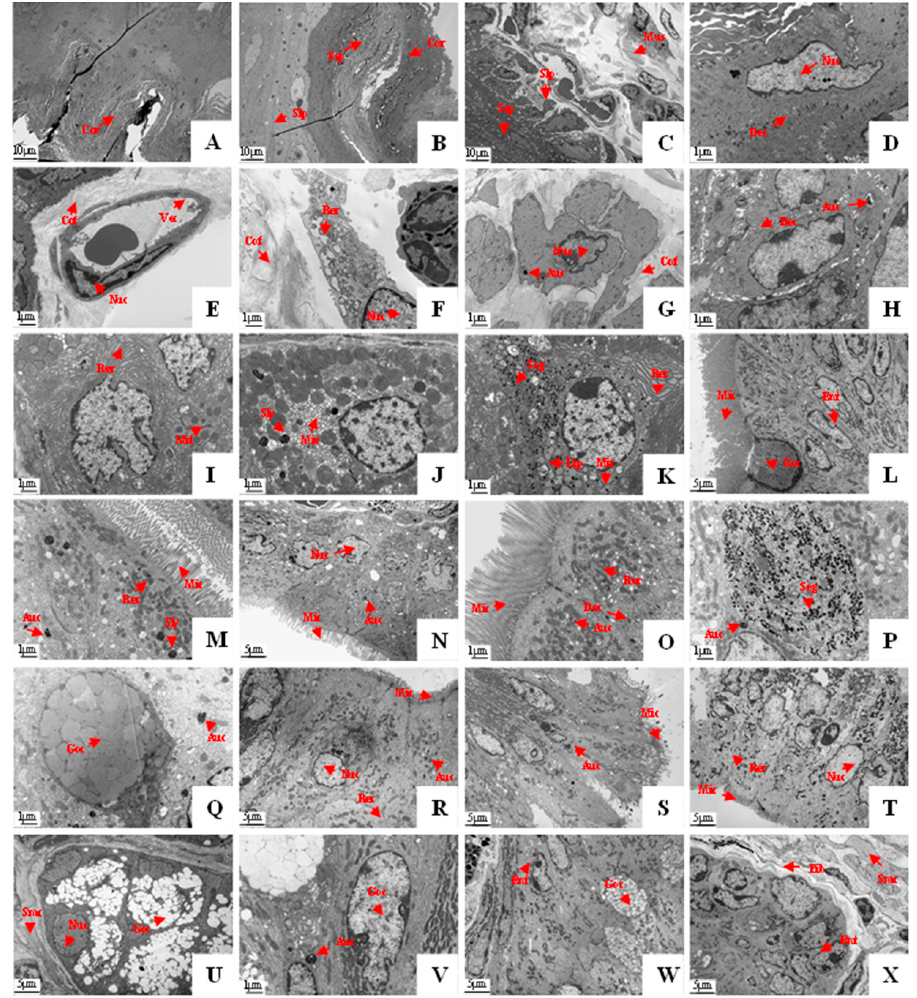
Figure 9. Ultrastructure of the gastrointestinal organs of the plateau zokor (( A – C ) 2400 × magnifi- cation; ( D – K , M , O – Q , V ) 12,000 × magnification; ( L , N , R – U , W , X ) 5000 × magnification). ( A – C ) The mucosal epithelium of the fundus, pylorus, and corpus I of the stomach; ( D ) the spinous cell of the gastric fundus; ( E ) the vascular endothelial cell of the gastric fundus; ( F ) the fibroblast of the gastric corpus I; ( G ) the smooth muscle cell of the gastric pylorus; ( H ) the squamous epithelial cell of the gastric corpus I; ( I – K ) the chief cell, parietal cell, and mucous cell of the gastric corpus II; ( L ) the epithelial cell and goblet cell of the ileum; ( M – O , R – T ) the epithelial cell of the duodenum, jejunum, ileum, colon, rectum, and cecum; ( P , Q , U – W ) the goblet cell of the duodenum, jejunum, colon, rectum, and cecum; ( X ) the submucosal lamina propria of the cecum. Auc: autophagy cells; Cof: collagen fibers; Cor: corneum; Dec: desmosome connections; Ent: enterocyte; Fib: fibroblast; Goc: goblet cells; Lip: lipid droplets; Mic: microvilli; Mit: mitochondria; Miv: microtubule vesicles; Mus: muscularis; Nuc: nucleus; Rer: rough endoplasmic reticulum; Seg: secretory granule; Slp: submucosal lamina propria; Sly: secondary lysosomes; Smc: smooth muscle cell; Ssp: stratum spinosum; Vec: vascular endothelial